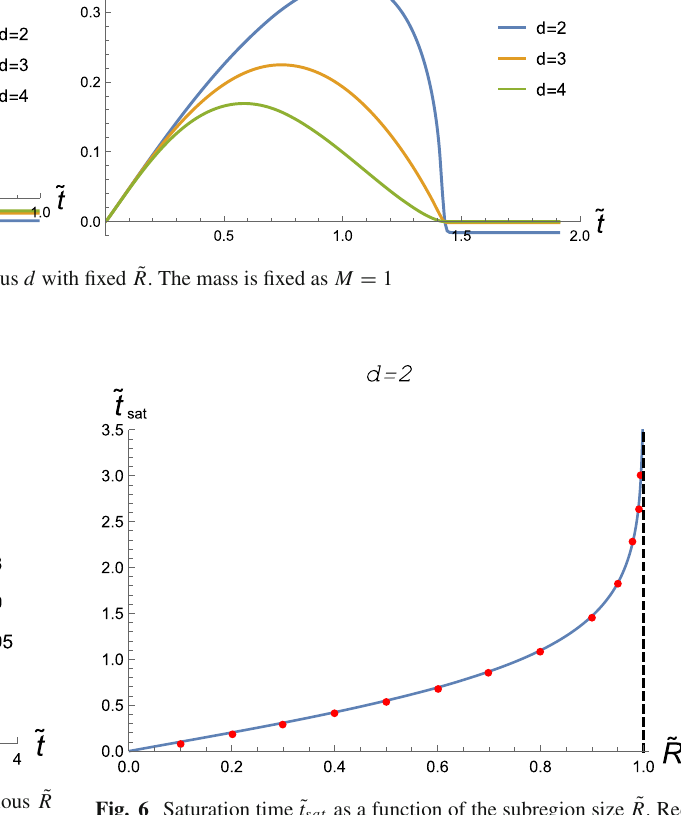
Fig. 6 Saturation time ˜ t sat as a function of the subregion size ˜ R . Red dots correspond to numerical results while the solid blue curve repre- sents the fitting function ˜ t sat = tanh − 1 ( ˜ R ) . Space dimension and mass parameter are fixed as d = 2 and M = 1, respectively growth slows down and after reaching a maximum it starts to drop down quickly, and shortly after the drop down stops and it gets to saturation finally. This picture is similar to that in flat boundary cases but with a strip subregion [56,92]. This implies that the time evolution behaviours of subregion com-